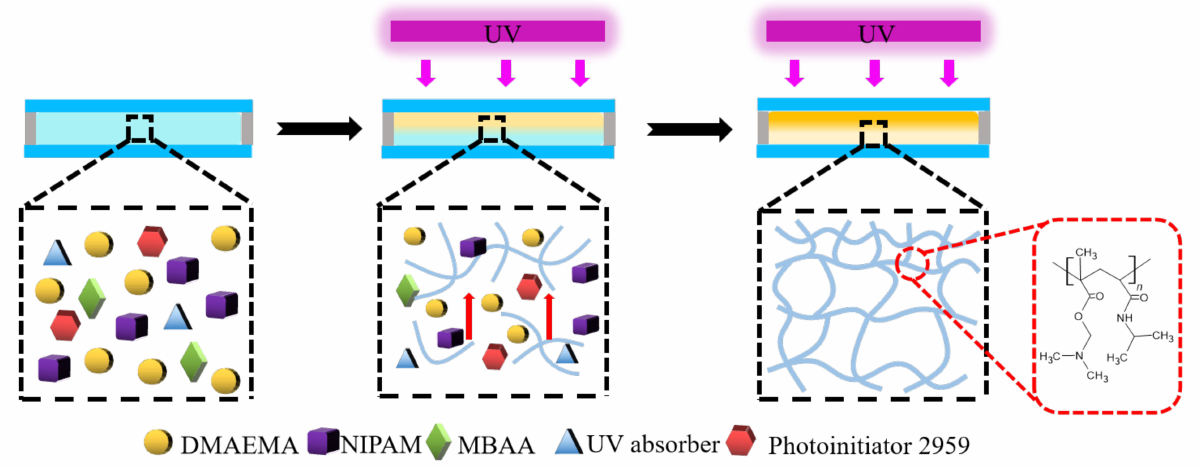
Figure 1. Preparation of self-powered gradient hydrogels with a reversible adhesion